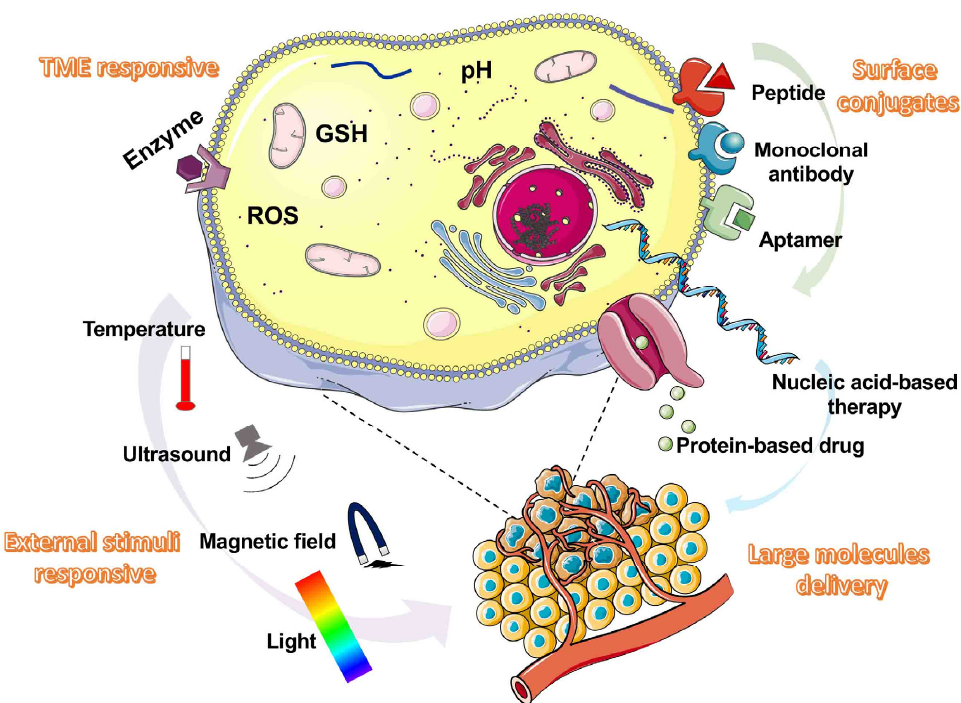
Figure 1 Figure 1. Main functional nanoparticles types in cancer